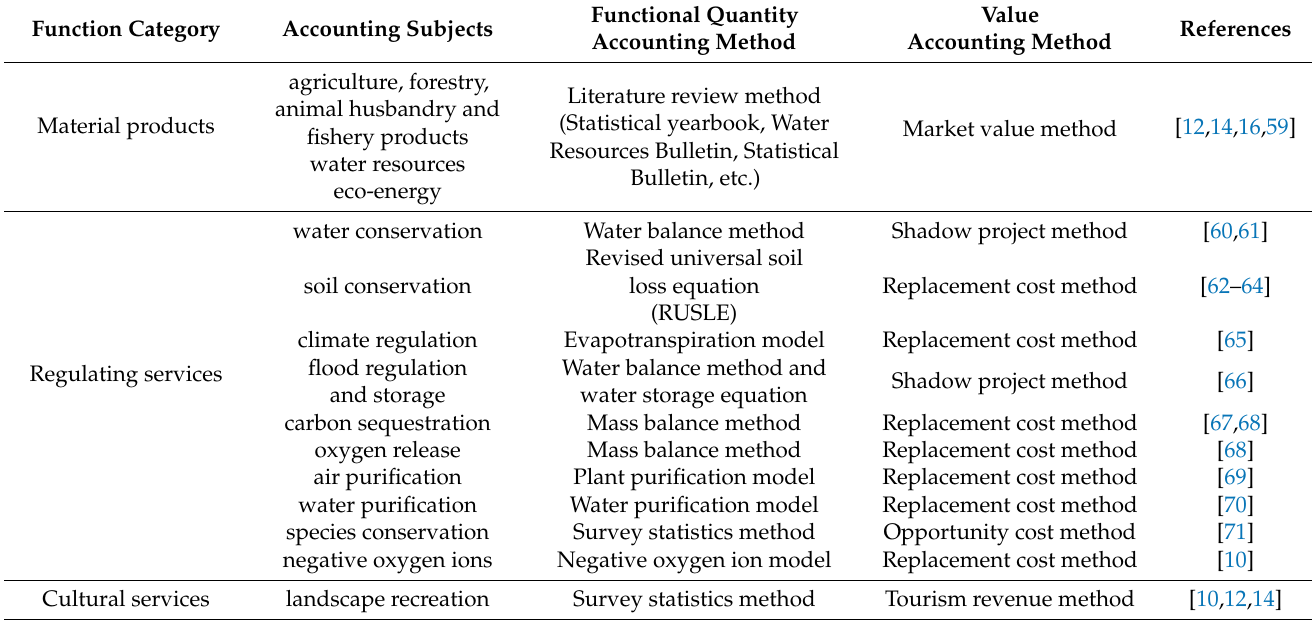
Table 1. GEP accounting